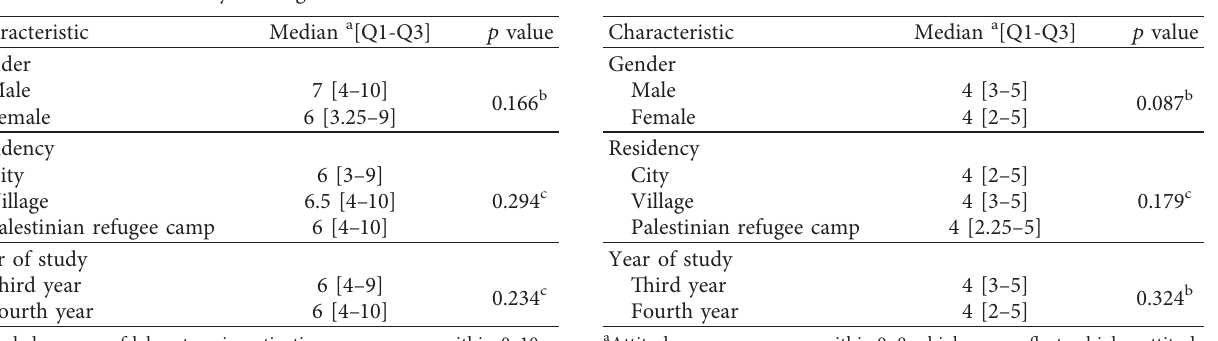
Table 11: Association between nursing students’ demographic characteristics and laboratory investigations score.